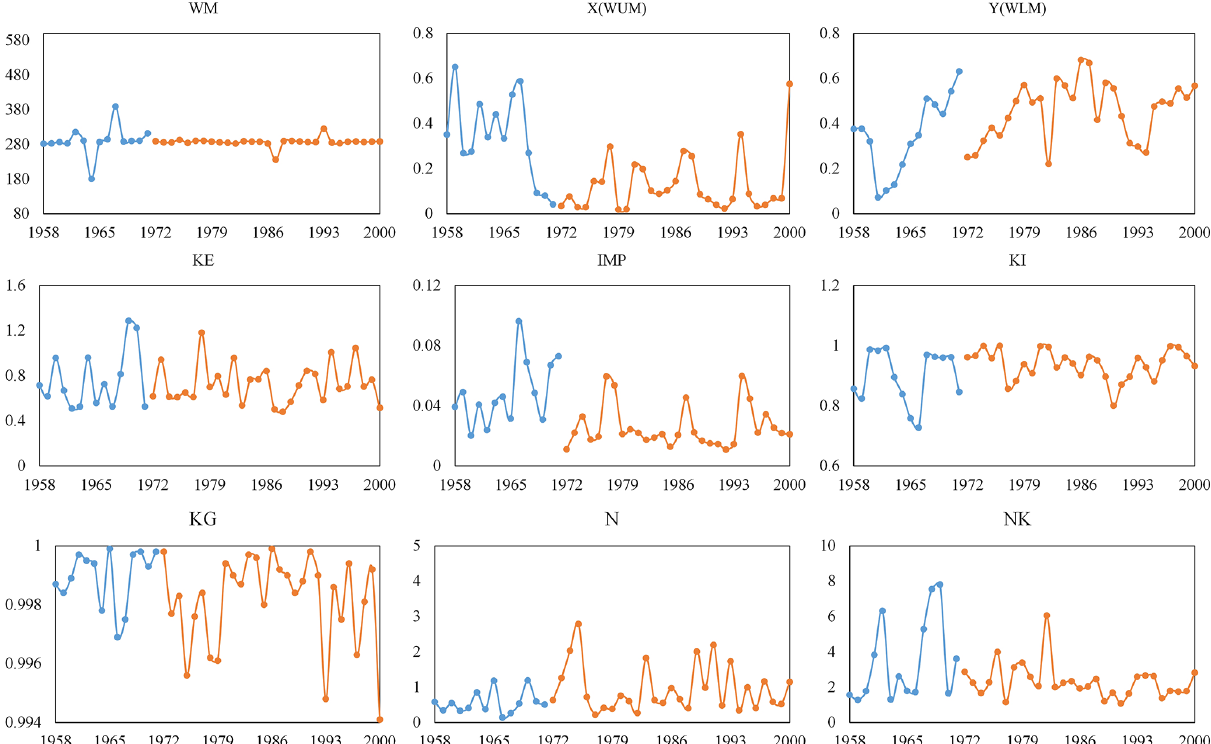
Figure 14. Estimated sensitive parameters of the Xinanjiang model for the Wuding River basin. The blue and orange solid lines represent the estimated parameters pre- and post-1972,